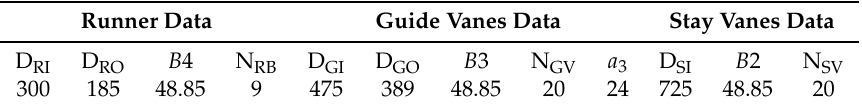
Table 1. Main characteristics of the model for the considered